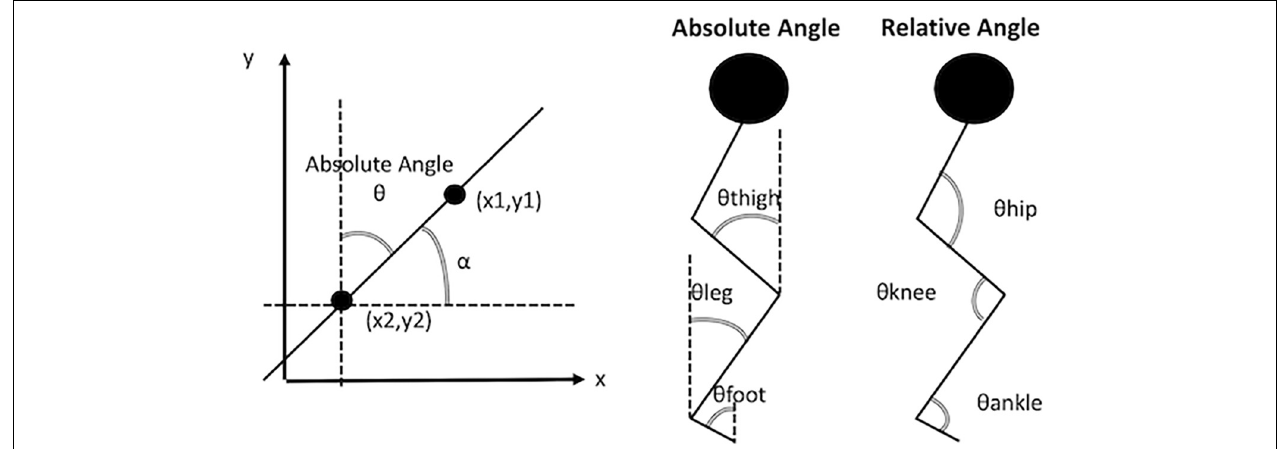
FIGURE 1 | Illustrative example of absolute angles and relative angles. In the panel (right) the absolute angle (cid:9) is the complementary angle of angle α . The angle α is obtained from the arctangent of the slope of the line passing through the points (x1, y1) and (x2, y2). In the panel (center) are depicted the absolute angles of thigh, leg, and foot. In the panel (left) are depicted the relative angle of the hip, the knee and the